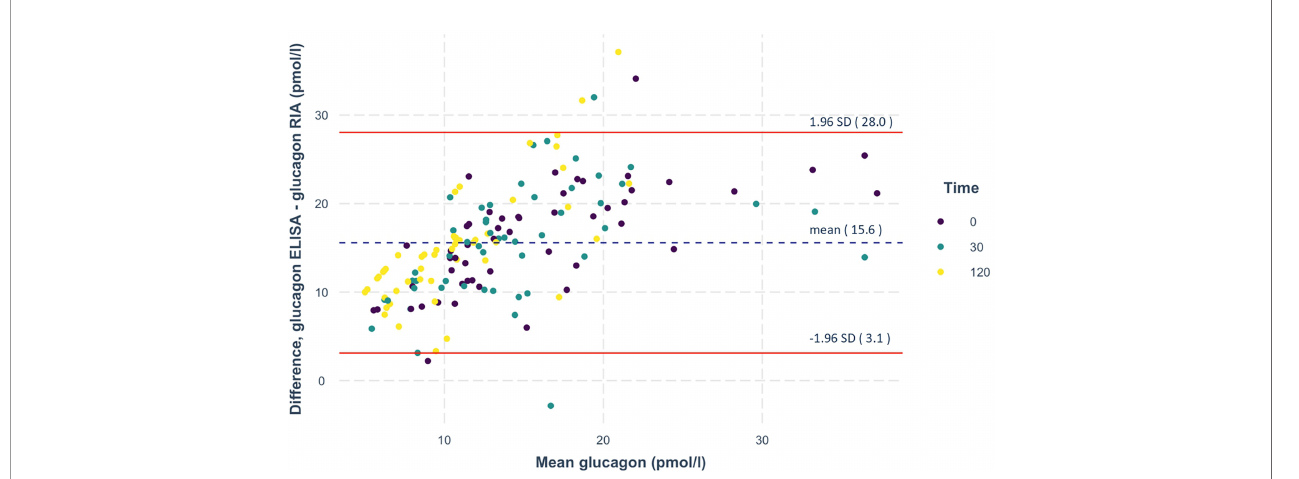
FIGURE 3 | Bland-Altman plot of the RIA- and ELISA-measured glucagon. Differences in glucagon measurements between the two assays are plotted against mean glucagon values. The dashed lines represent the mean, the solid lines depict the lines of agreement calculated as mean ± 1.96 times the SD of this difference. N=156 measurements from 52 oGTTs.